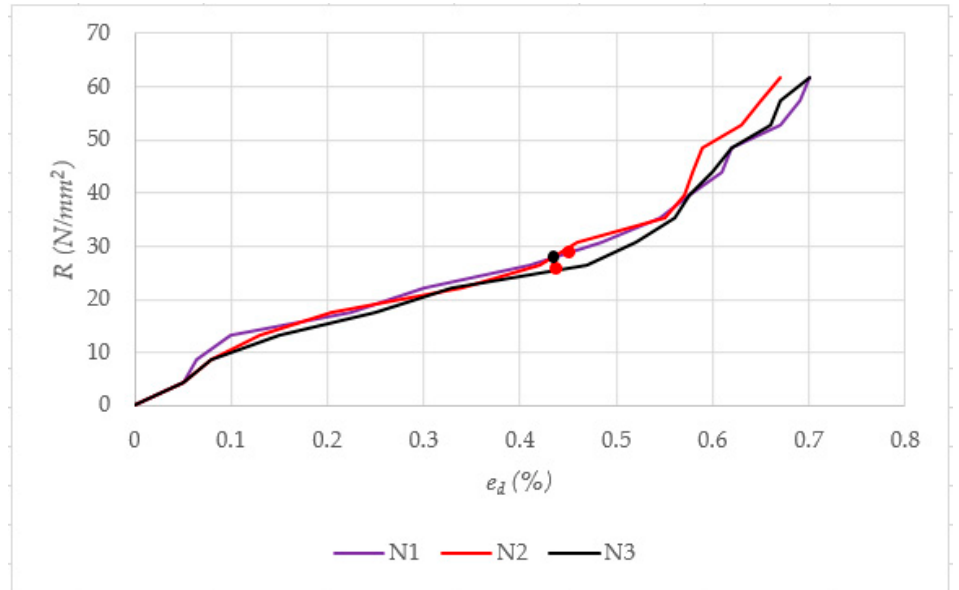
Figure 10. Stress–strain curves for samples without reinforcements.